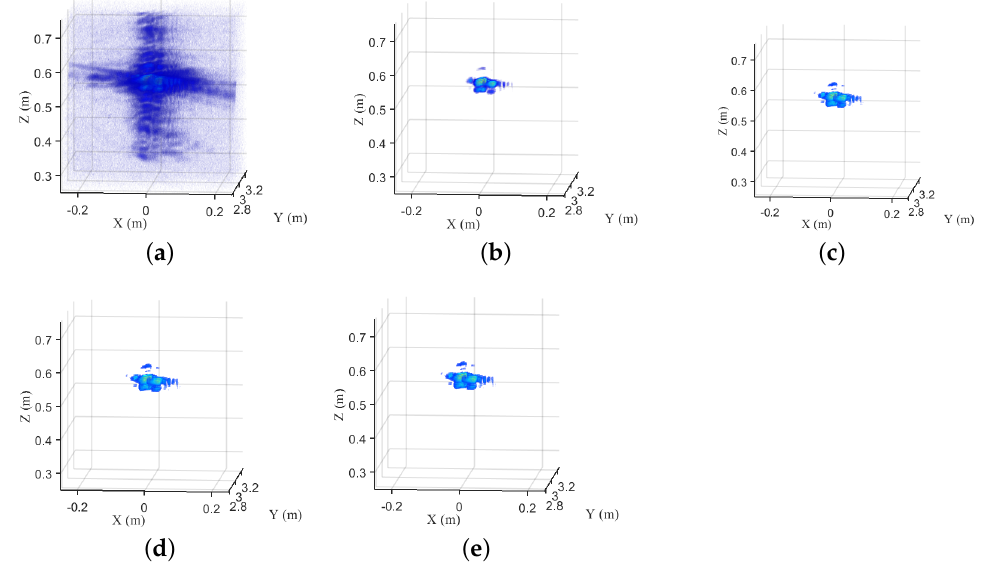
Figure 7. The imaging results of the corner reflector corresponding to the 75% sampling rate. ( a ) The MF result. ( b ) The FIST result. ( c ) The SCAD result. ( d ) The MCP result. ( e ) The GSALSA–Cauchy